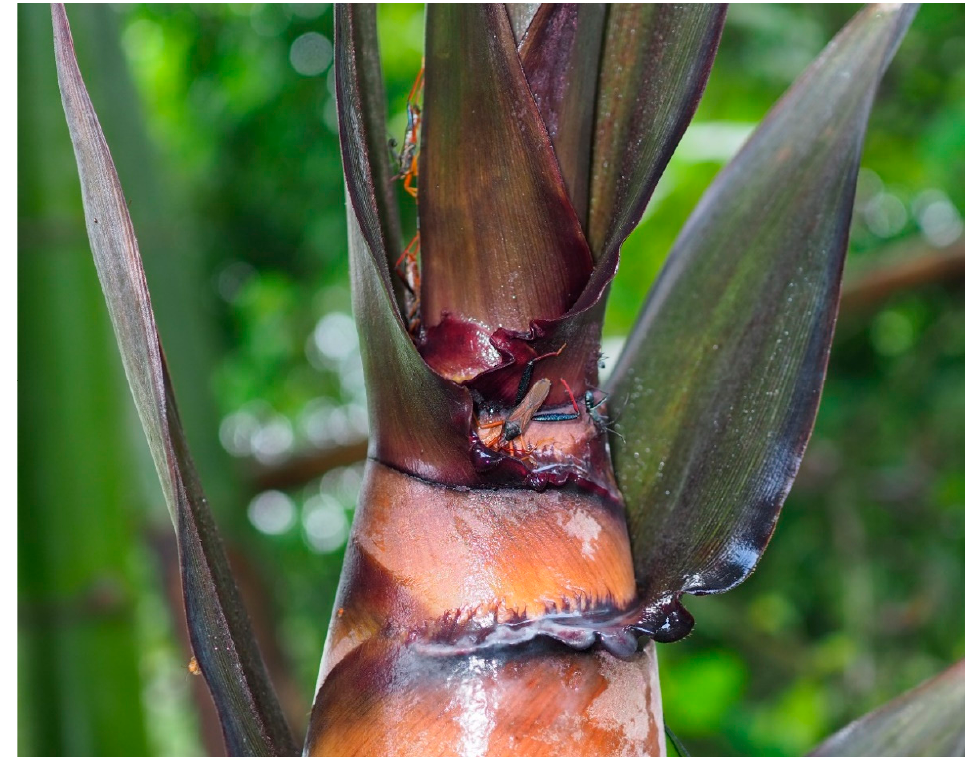
Figure 6. Field picture of N. bispina sp. nov. at Xiaomengyang, Xishuangbanna, Yunnan, China. Key to the species of Notobitiella